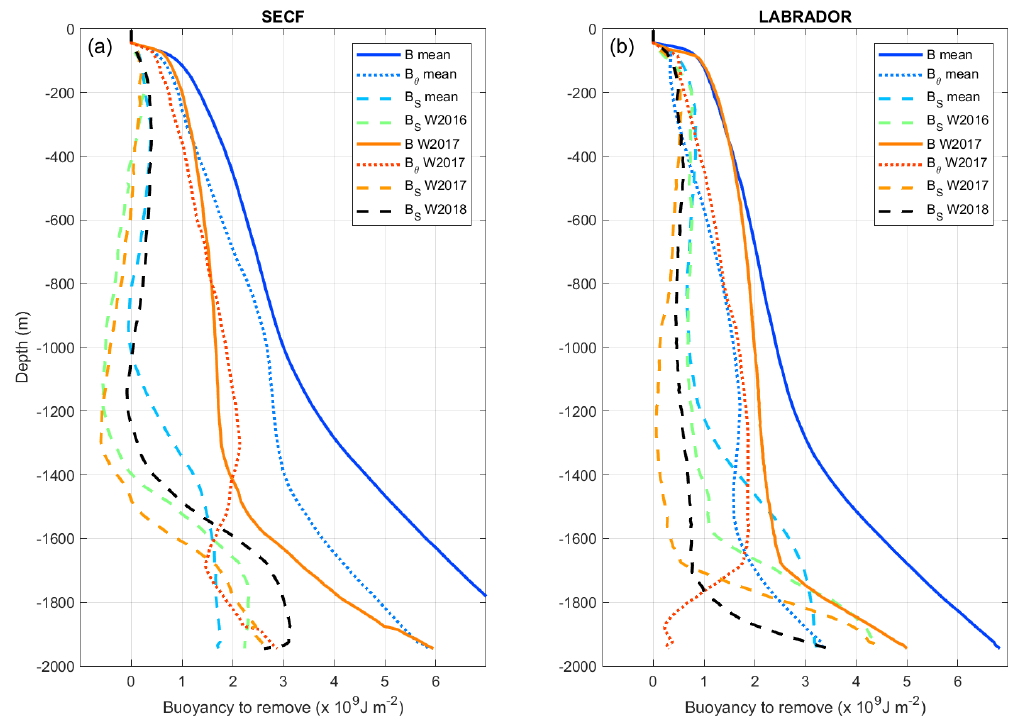
Figure 7. Decomposition of the profiles of buoyancy to be removed ( B , continuous lines) in its thermal ( B θ , dotted lines) and salinity ( B S , dashed lines) components in (a) the SECF region; (b) the Labrador Sea. The B S components for W2016 and W2018 were added to show the evolution of the depth of the deep halocline.